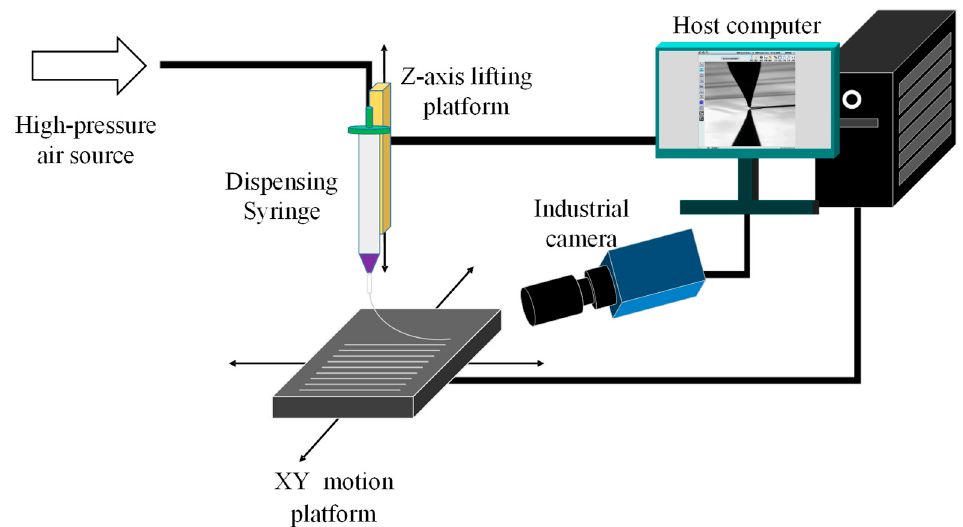
Figure 1. Conductive paste 3D printing experimental platform.